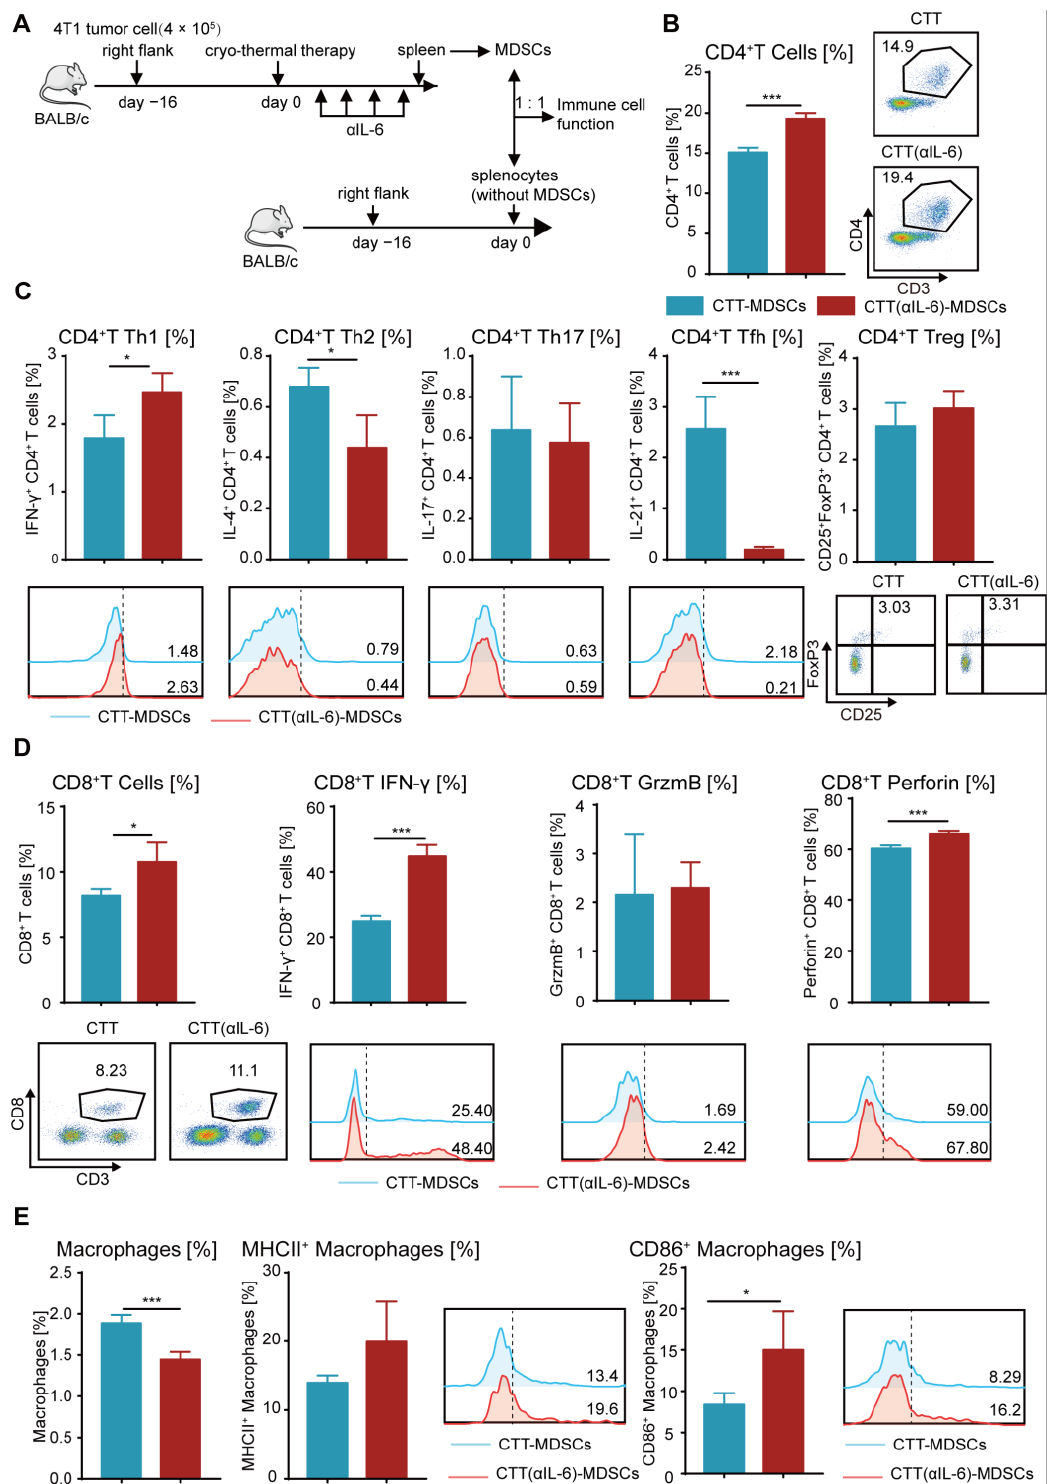
Figure 6. Mature MDSCs after combination therapy promoted the antitumor function of other immune cells. ( A ) Scheme of experiment design. ( B ) The proportion of CD4 + T cells. ( C ) The subsets of CD4 + T cells. ( D ) The proportion and cytokines of CD8 + CTLs. ( E ) The proportion and mature phenotype of macrophages after coculture with MDSCs from different groups in vitro. n = 4 for each group. * p < 0.05, *** p < 0.001. Data for graphs were calculated using two-sided Student’s t -test. CTT, cryo-thermal